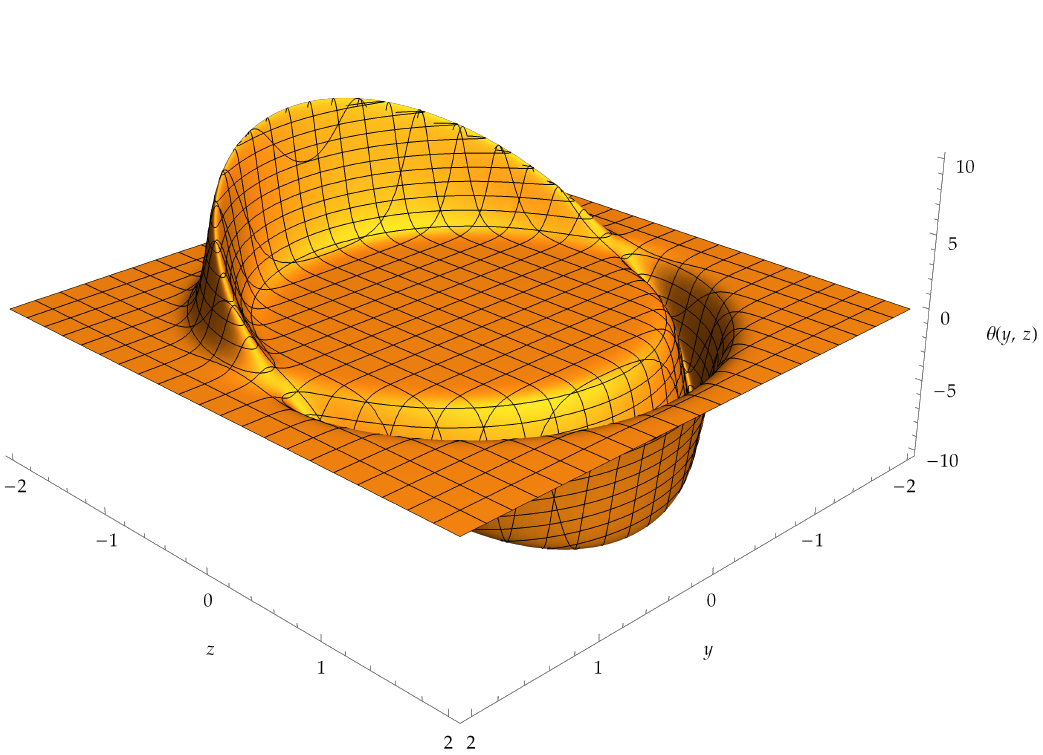
Figure 4: A plot of the expansion θ of a warp drive bubble with v = 2, R = 1.5, and (cid:34) = 0.1 moving along the positive z